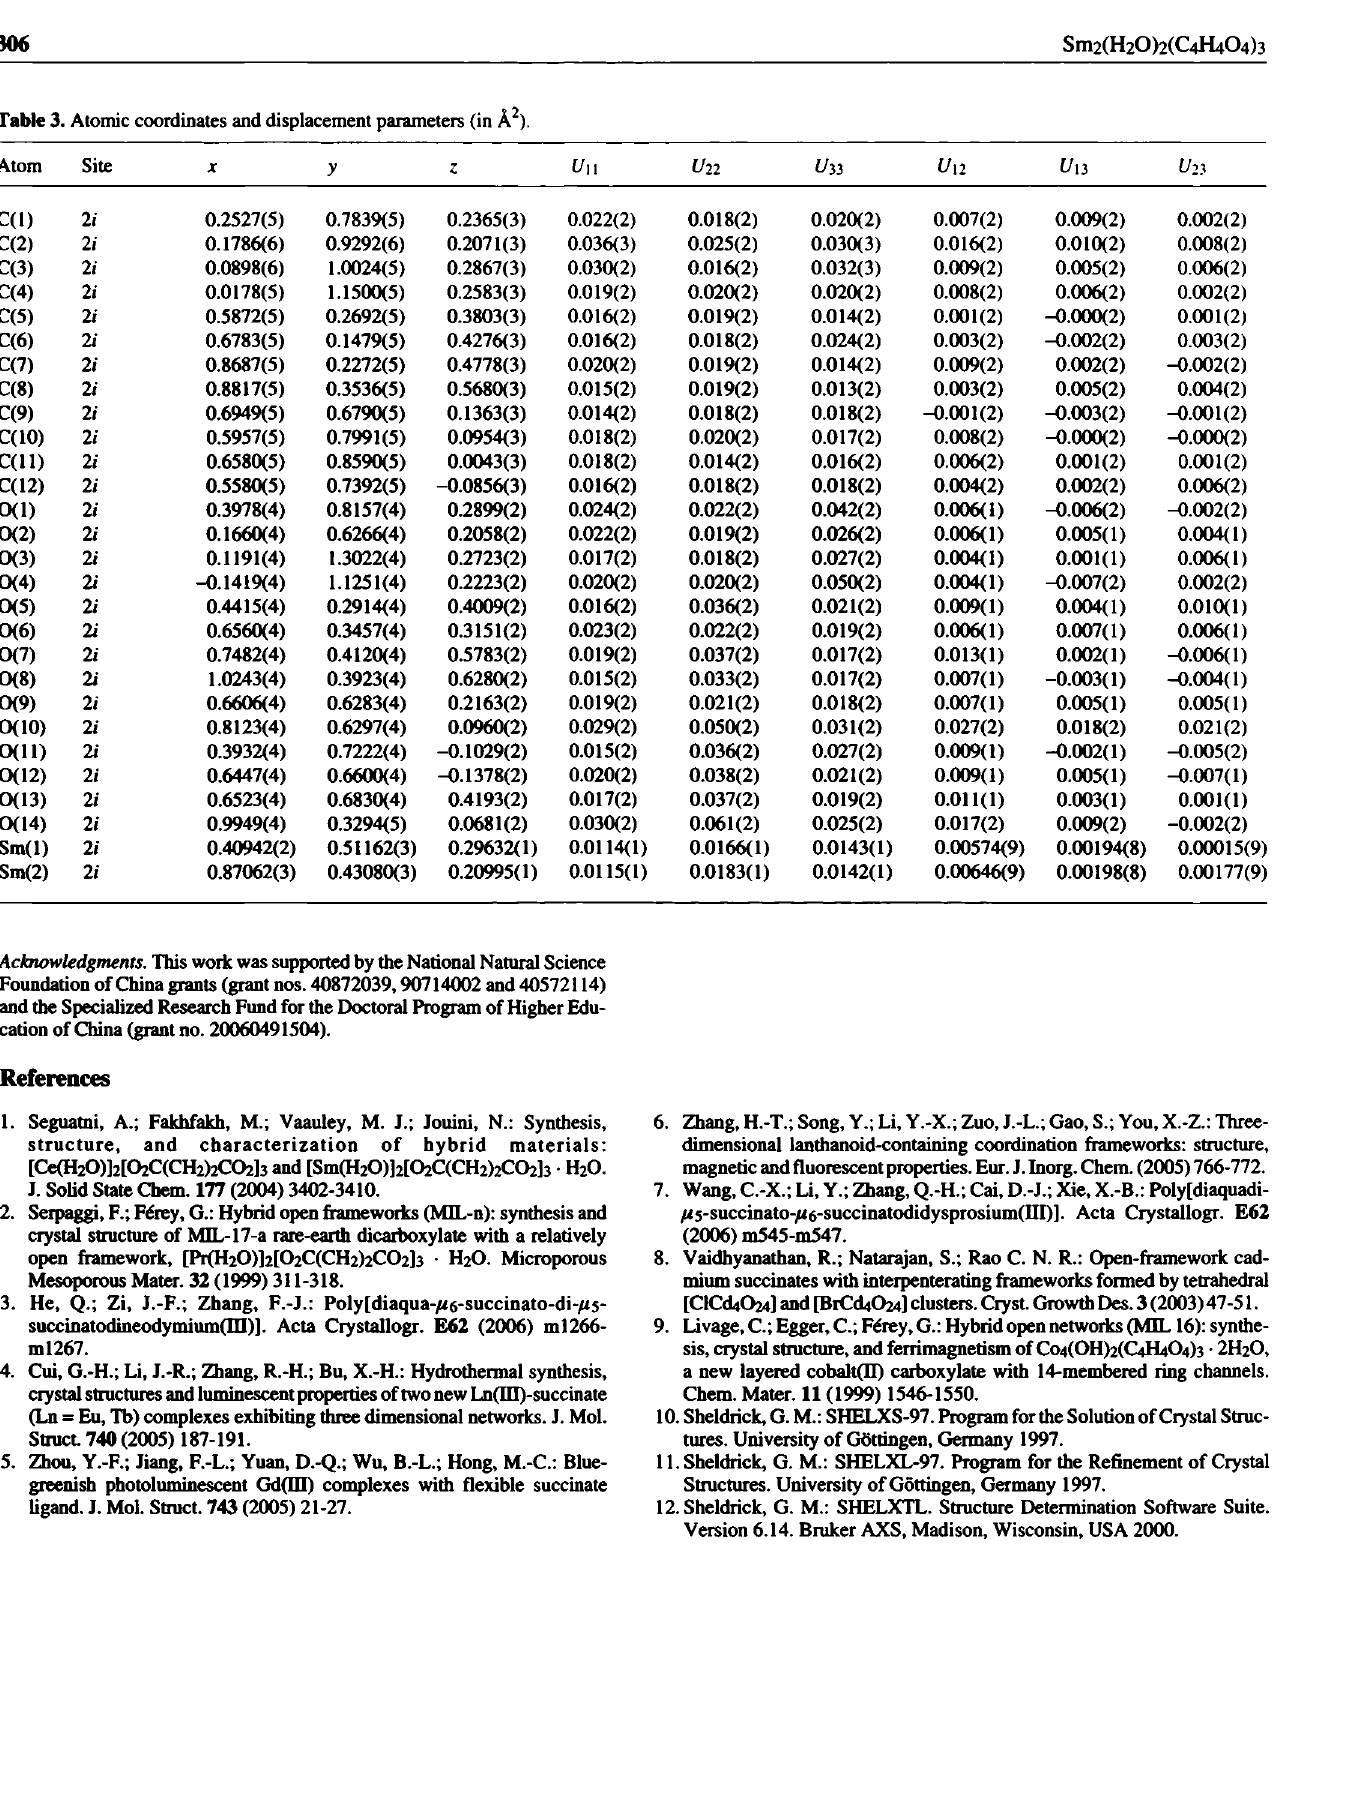
Table 3. Atomic coordinates and displacement parameters (in Â 2